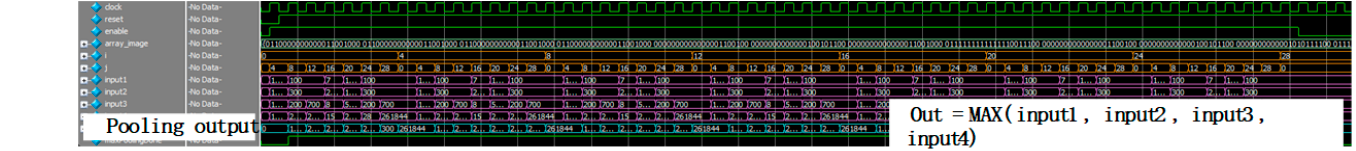
Figure 19. The simulation result of fully connected operation. The top simulation results of the CNN system are described in Figure 20. Compared 10 outputs of final fully connected layer, the maximum value can be found which repre- sents final classification results. It can be achieved by (7), (cid:1851) = (cid:1839)(cid:1827)(cid:1850)((cid:1853)1, (cid:1853)2, (cid:1853)3, (cid:1853)4, (cid:1853)5, (cid:1853)6, (cid:1853)7, (cid:1853)8, (cid:1853)9) (7) where Y is the final output of the classification results. The fully connected operation re- sults are (cid:1853)1– (cid:1853)9 . Figure 20a–d shows the classification results when the input digit is 3, 5, 6, 8 separately. ( a ) The top simulation result of digit 3. ( b ) The top simulation result of digit 5.